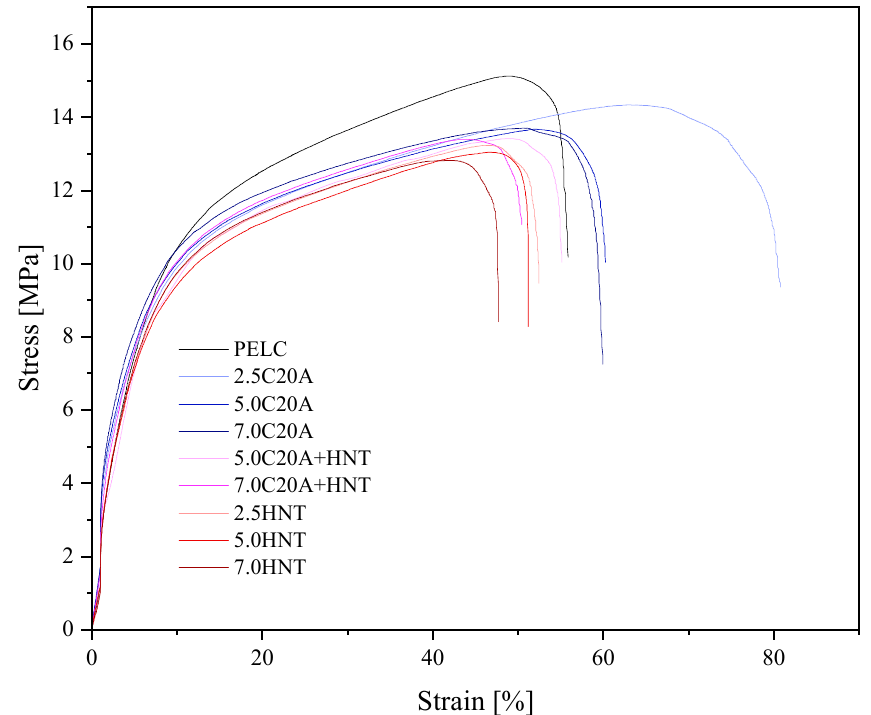
Figure 10. Representative stress–strain curves for the series of nanocomposites based on